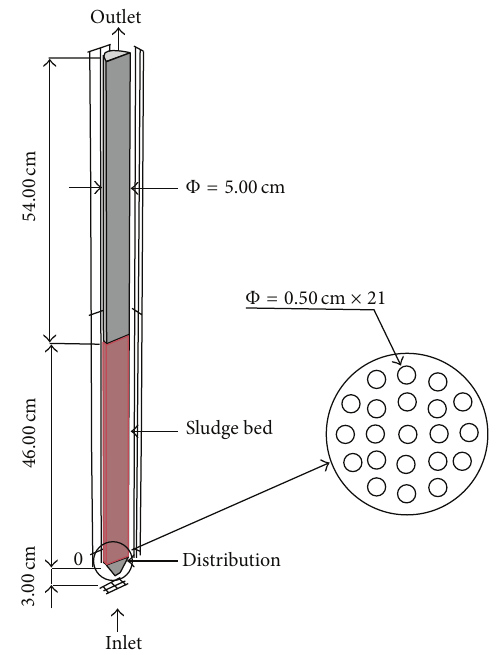
Figure 1: Schematic view of the modelling